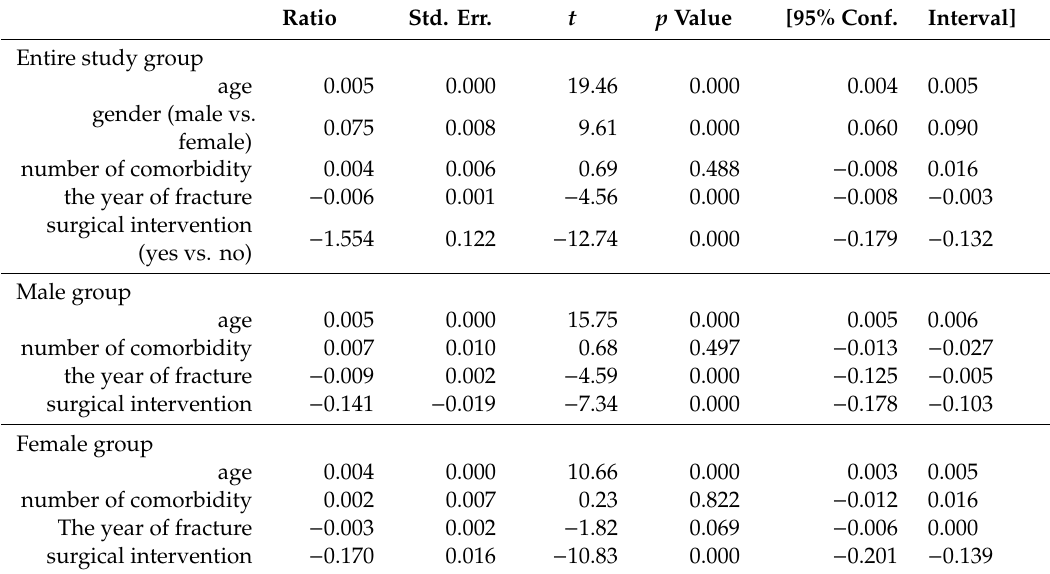
Table 4. Results of logistic regression of first-year mortality odds.